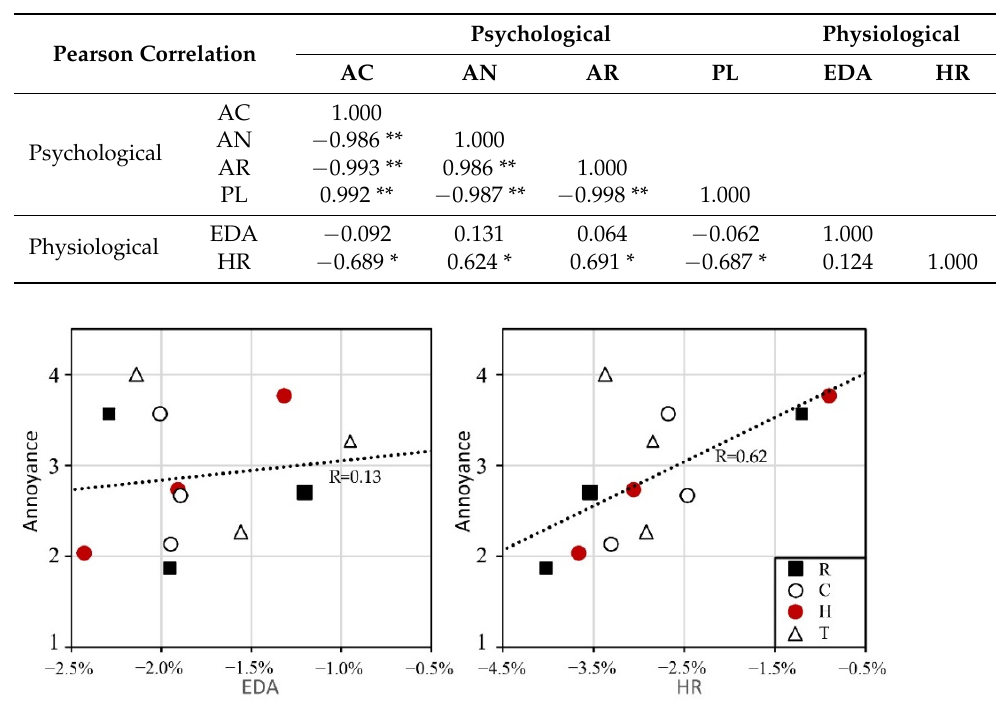
Figure 10. Relationship between psychological response (annoyance) and physiological